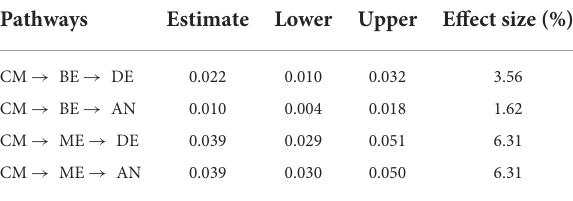
TABLE 4 Standardized indirect effects and 95% confidence intervals.